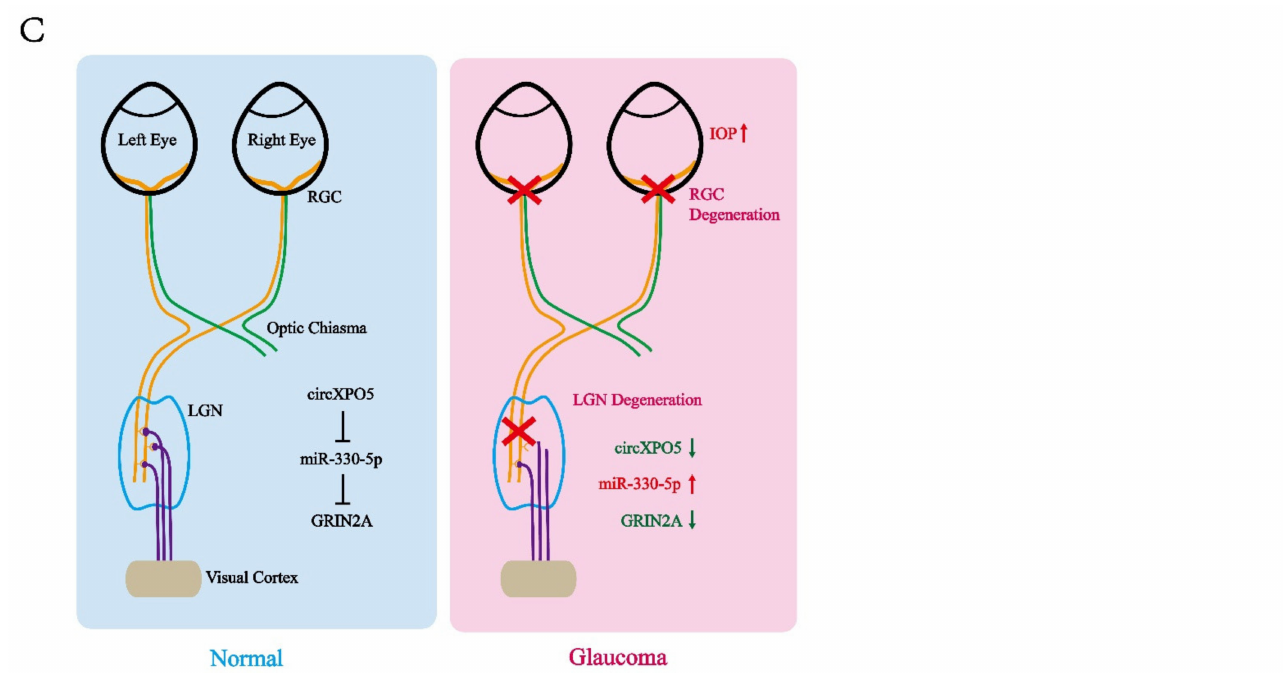
Figure 6. Detection expression of circXPO5 and miR-330-5p in LGN of macaque glaucoma model. ( A ) QPCR detection of circXPO5; ( B ) QPCR detection of miR-330-5p; ( C ) mechanism model of circXPO5/miR-330-5p/GRIN2A in glaucoma LGN degeneration. ***, p <